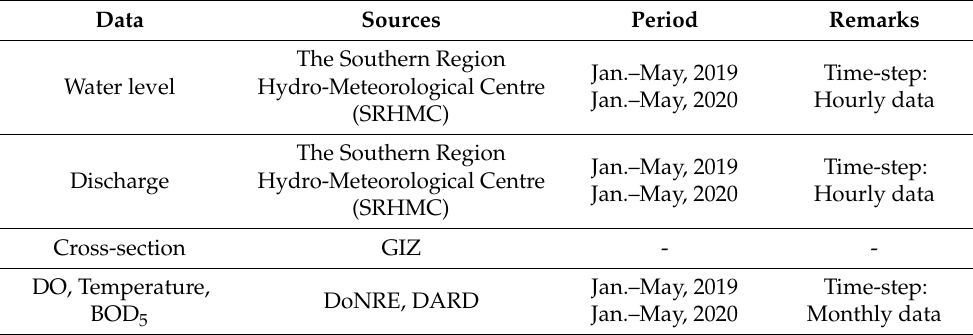
Table 1. Summary of hydrology and water quality data collection and